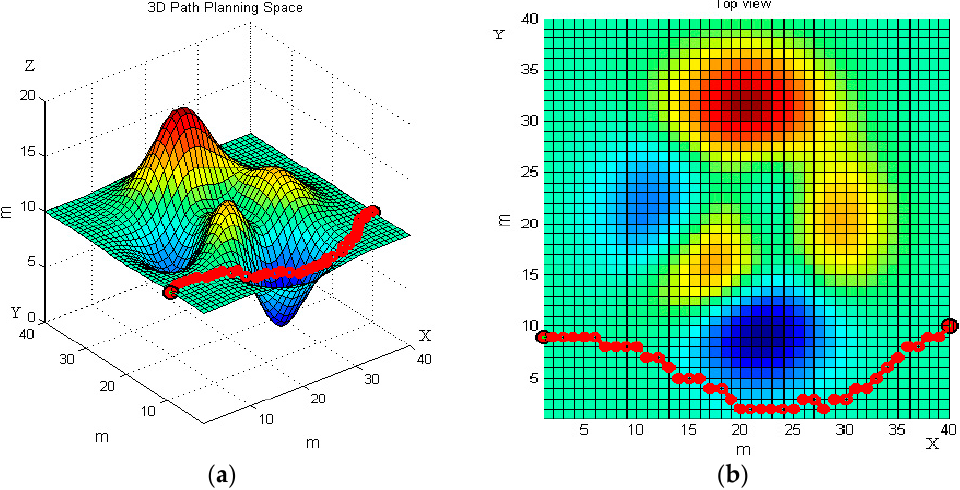
Figure 8. The robot’s moving trajectory using the improved ant colony algorithm in the first terrain. ( a ) Front view; and ( b ) top view.